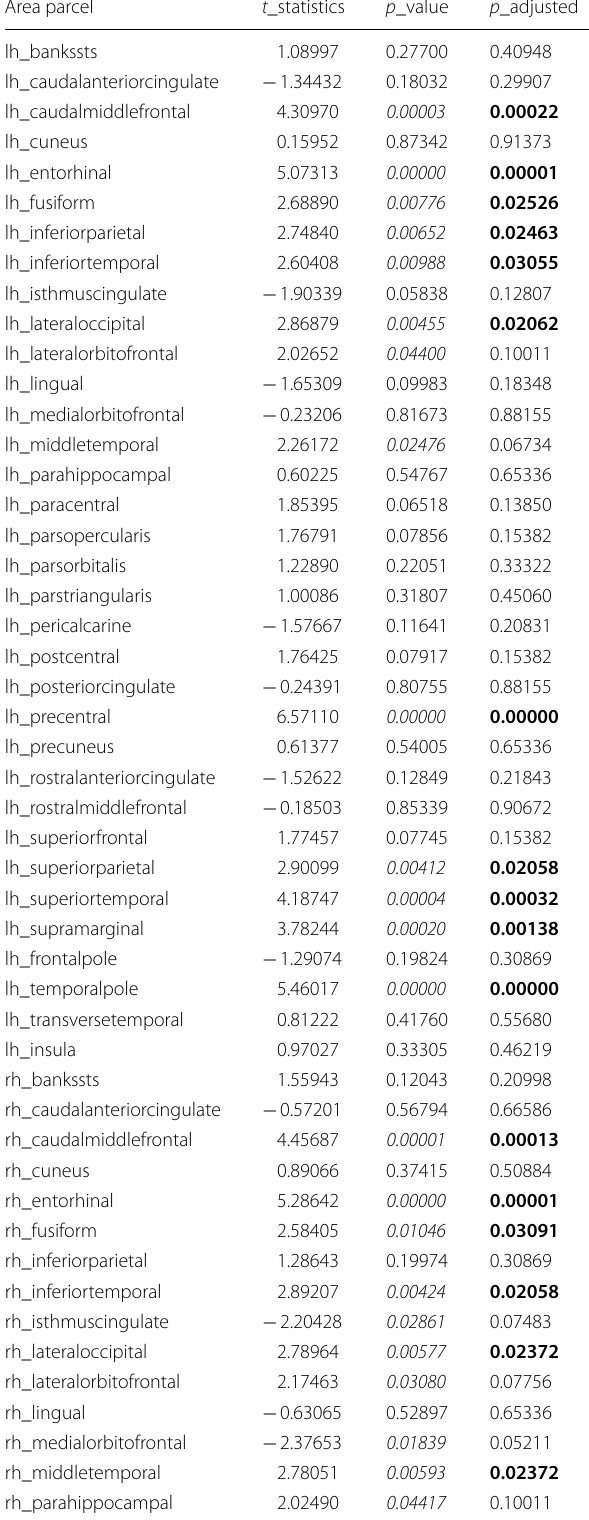
Table 3 Relations between cortical thickness and structural MRI quality (as measured by the CAT12 Toolbox)